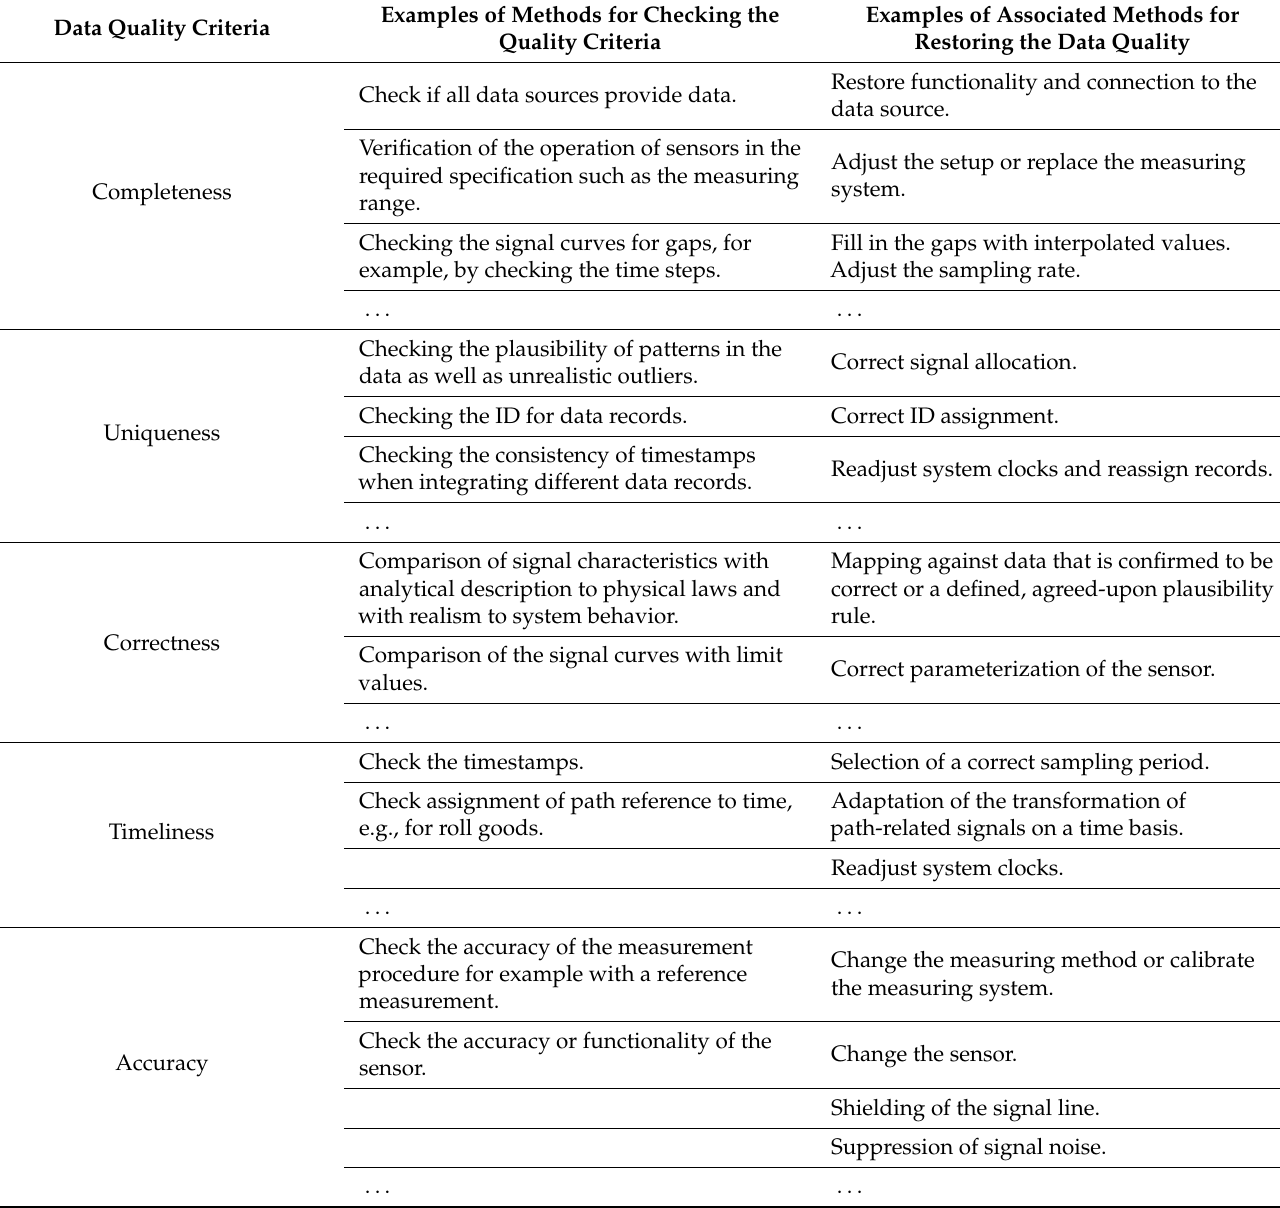
Table 1. Data quality criteria and examples of corresponding methods for quality inspection as well as for quality restoration using the example of signal data. Data Quality